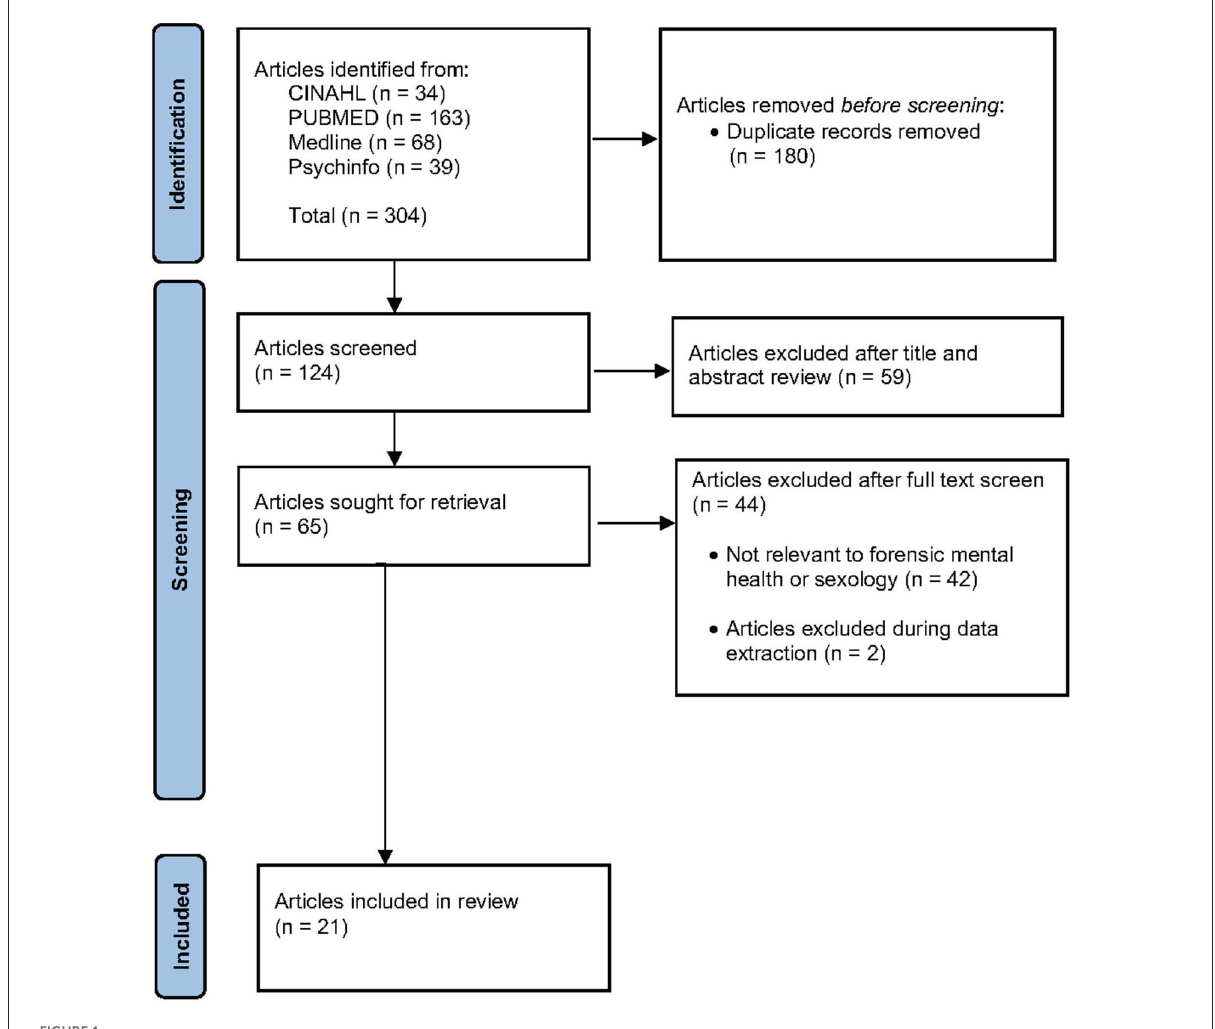
FIGURE1 Study selection flow